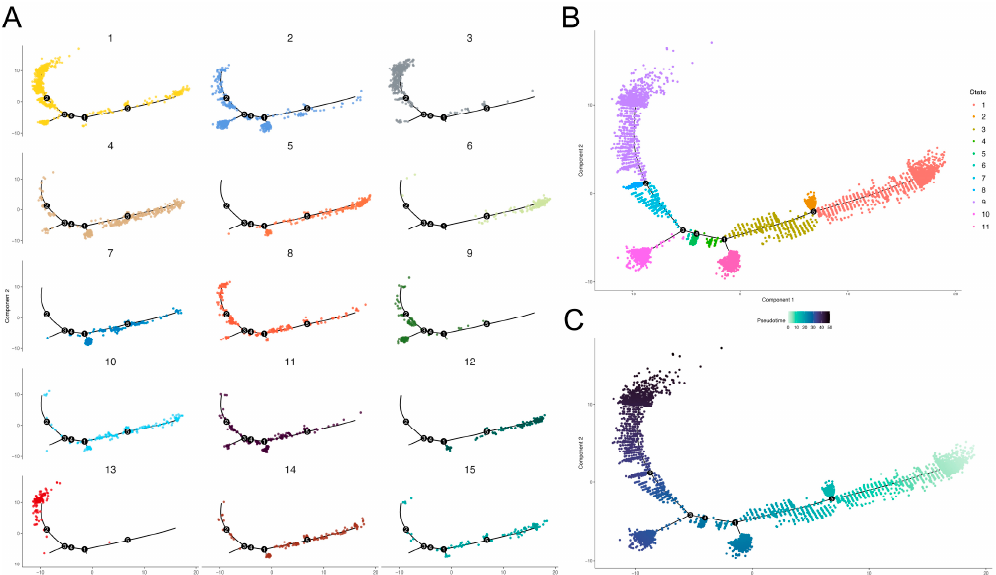
Brain Sci. 2022 , 12 , x FOR PEER REVIEW